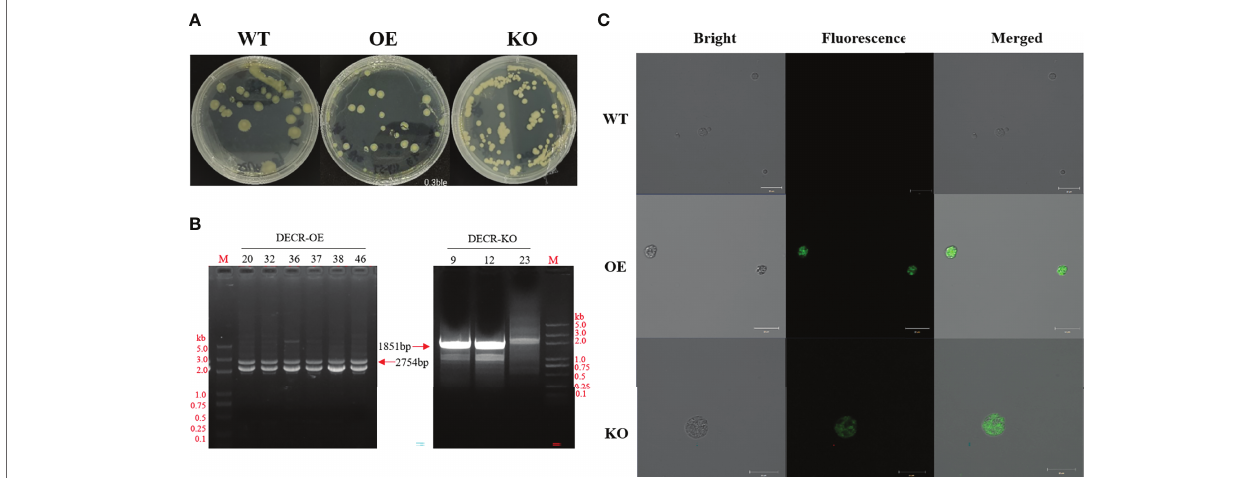
FIGURE 2 | Obtaining and identifying the transformants. (A) Screening transformants through Zeomycin resistance (0.3 mg mL −1 ). Yellow clones were visible after 24–48 h, and transformants were kept in an M4 plate containing 0.3 mg mL −1 Zeomycin. Left, wildtype (WT) grown on an M4 solid plate. Centre and right, DECR overexpression (OE) and knockout (KO) mutants grown on M4 plates containing 0.3 mg mL −1 bleomycin, respectively. (B) PCR verification of transgenic Aurantiochytrium sp. SZU445 with OE-overlap and KO-overlap. Specific fragments of 2754 bp and 1851 bp were amplified from the genome of OE and KO transformants, respectively; 20, 32, 36, 37, 38, and 46 are the transformants with the OE cassette, and 9, 12, 23 are the transformants with the KO cassette. M, DL 5000 DNA Marker. (C) Confocal microscope observations of the green fluorescence produced by EGFP expression in OE and KO mutants. WT has no autofluorescence. Scale bar: 20